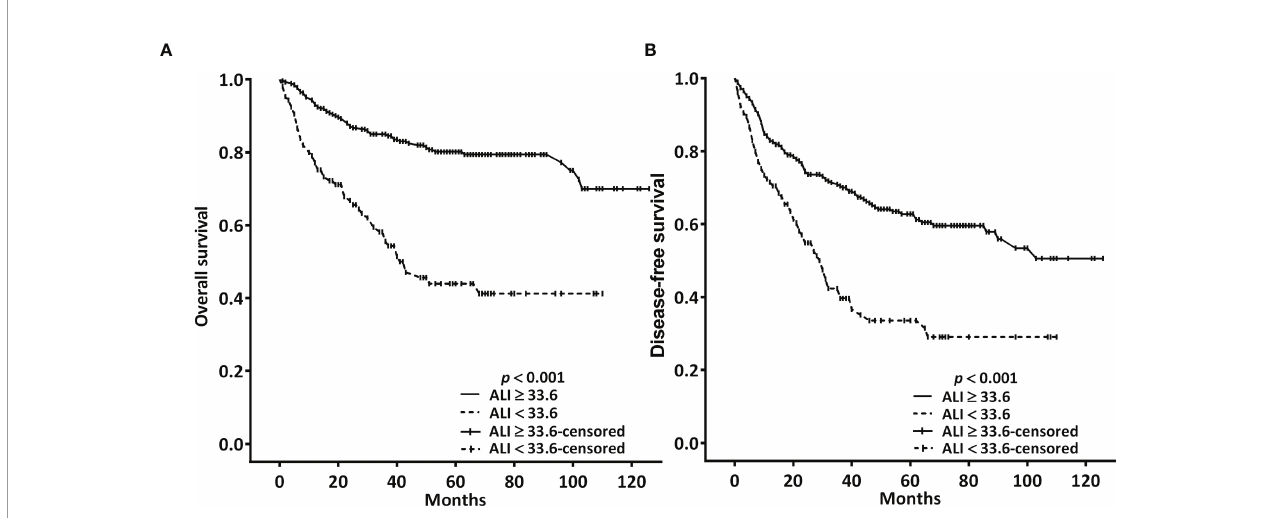
FIGURE 2 | Kaplan – Meier curves for (A) OS and (B) DFS of OSCC patients with ALI of ≥ 33.6 and